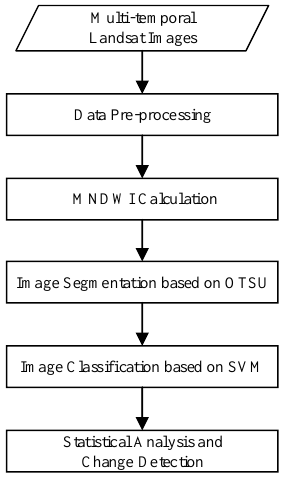
Figure 3. Schematic representation of the methodology The workflow includes four major stages: MNDWI calculation, image segmentation, image classification, and change